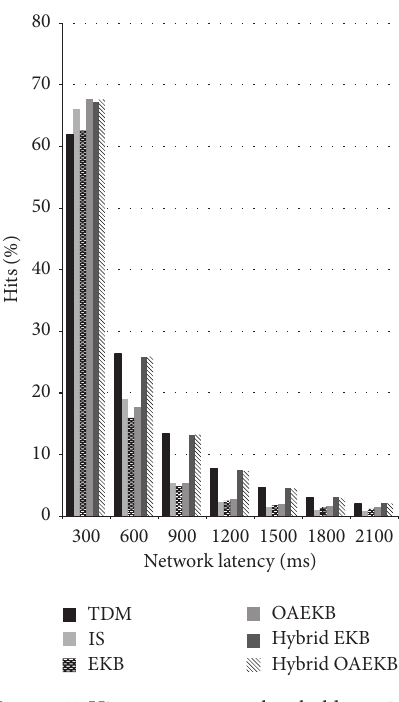
Figure 11: Hit percentages at threshold 𝑔 = 45 .